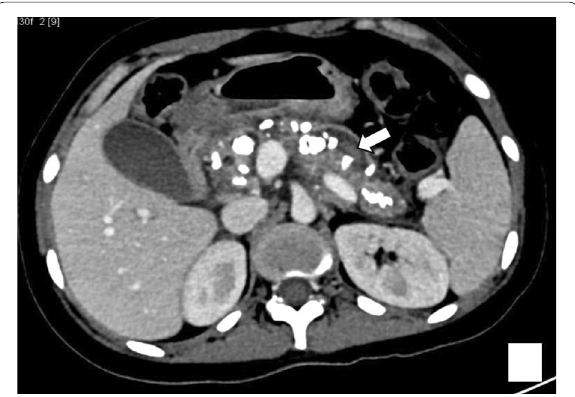
Fig. 2 CECT abdomen venous phase showing the hyperdense filling defect (white arrow) within the dilated main pancreatic